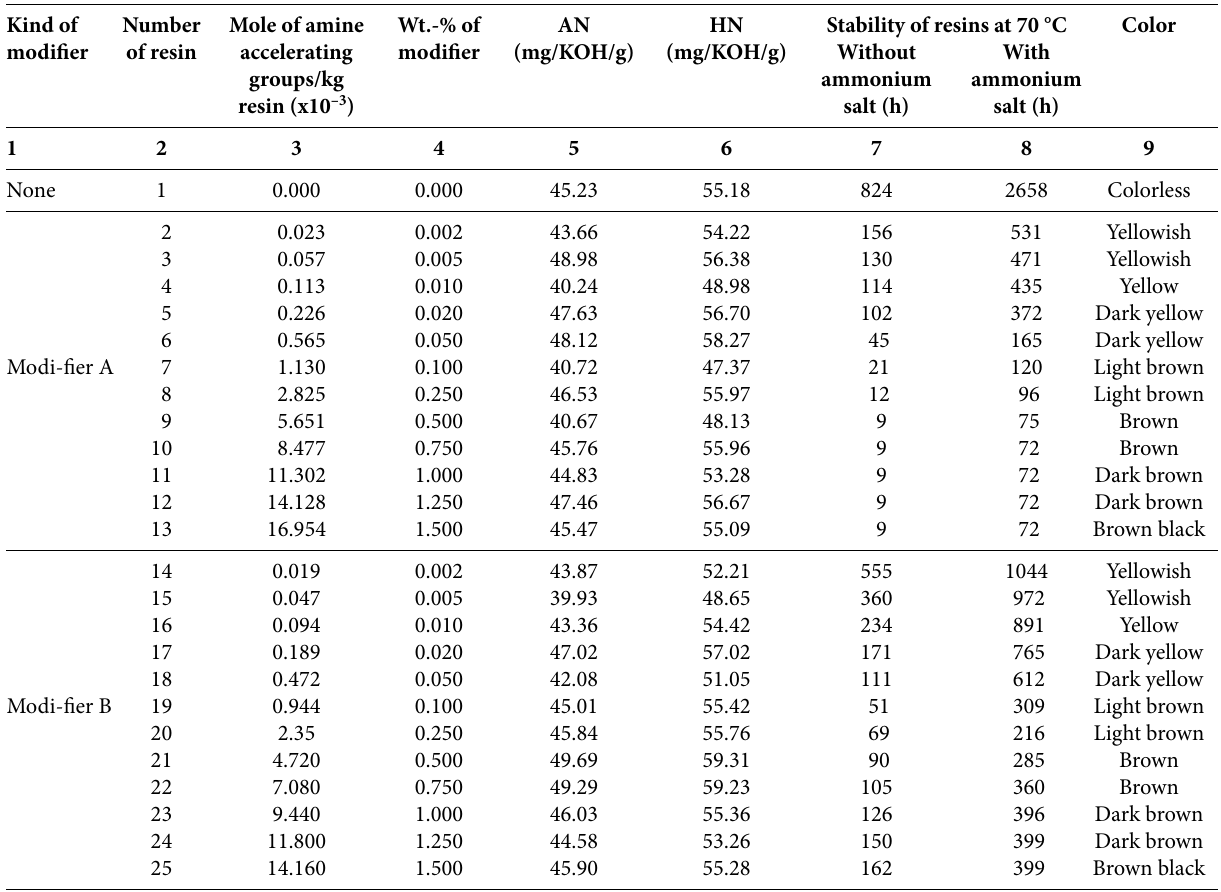
Table 5. Characteristic of UP Resins with Amine Modifiers Incorporated into Their Chemical Structure Kind of Number Mole of amine Wt.-% of